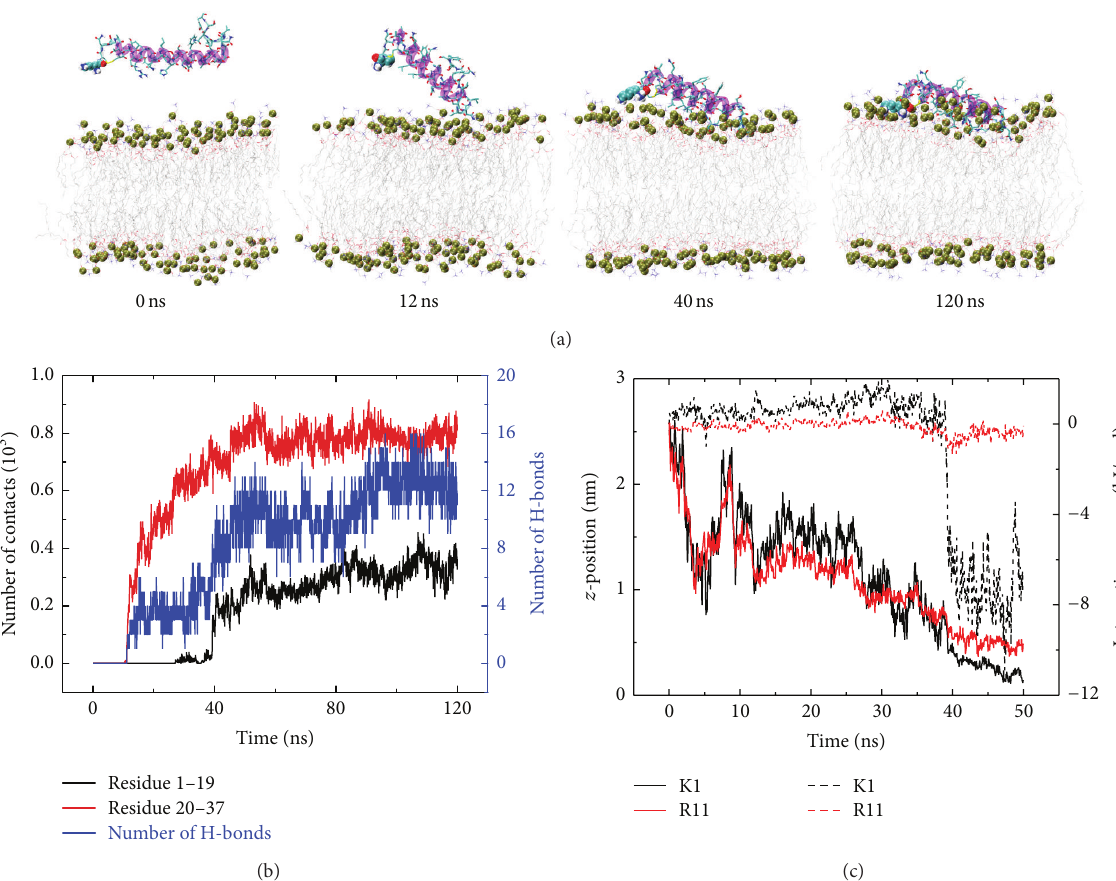
Figure 3: Detailed analysis of a representative MD trajectory of hIAPP adsorption to POPC bilayer surface, starting from the initial state S(0). (a) Snapshots at 𝑡 = 0 , 12, 40, and 120 ns. Each snapshot is displayed using the same representations as those used in Figure 1. (b) Time evolution of the number of contacts and the number of H-bonds between hIAPP peptide and the POPC lipid bilayer. (c) Time evolution of 𝑧 - position and interaction energy between lipid bilayer and the negatively charged residues K1 (black) and R11 (red). The solid and dashed lines correspond to 𝑧 -position and interaction energy, respectively. We only present the data of first 50 ns in order to show the initial adsorption process